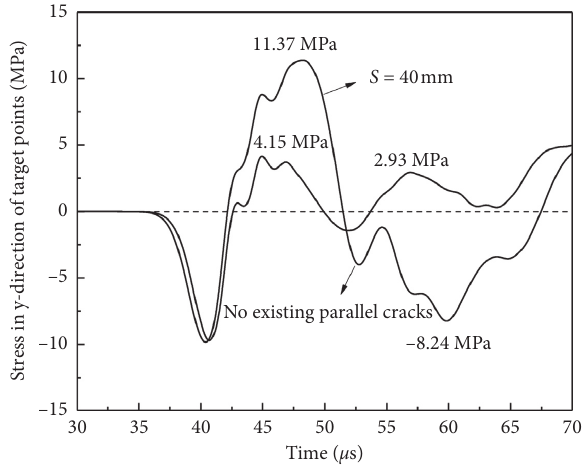
Figure 15: The stress history curves of the target points.